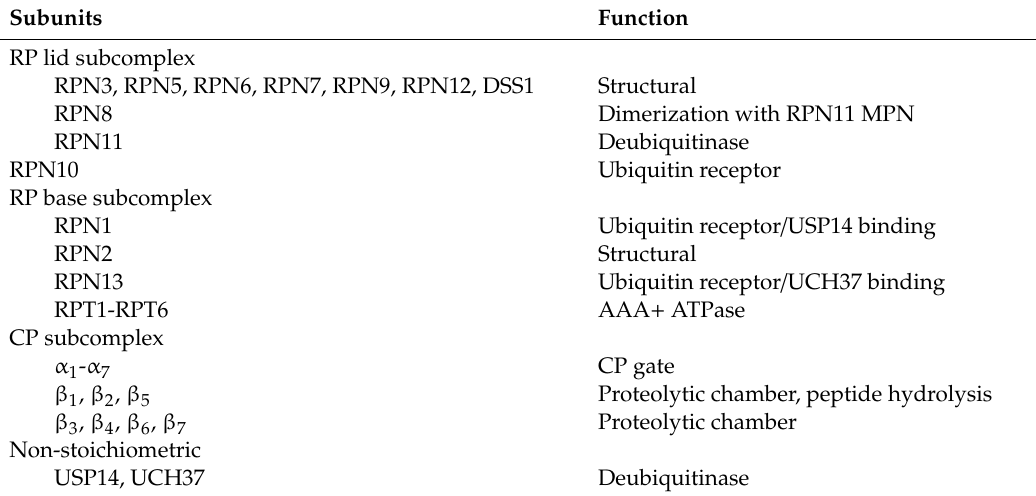
Table 1. Subunits and function of the human 26S